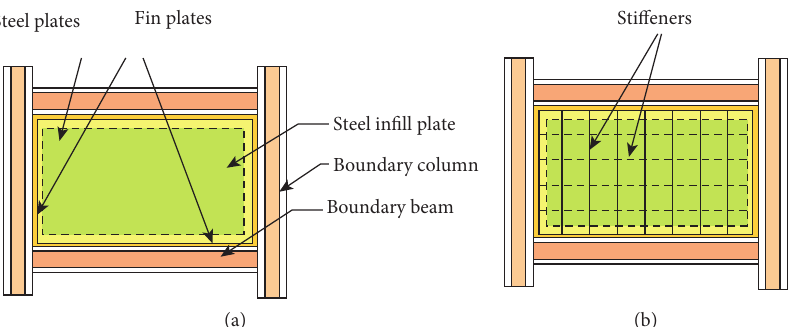
Figure 1: A scheme of a steel shear wall (SSW) in steel structures in the presence and absence of a stiffener [5]. (a) Unstiffened steel shear wall. (b) Stiffened steel shear